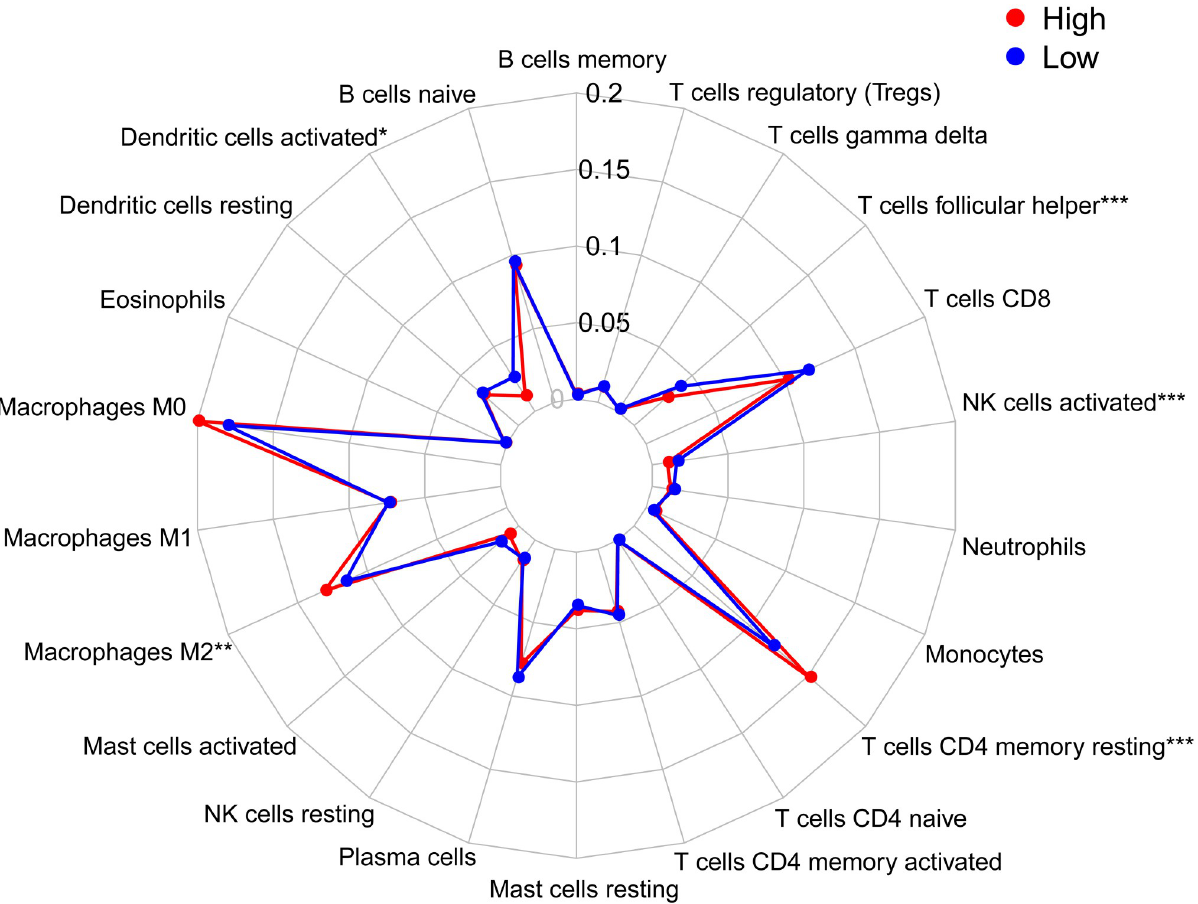
Fig 11. The radar charts depict a comparative summary of various immune cells in these two risk groups ( � P < 0.05, �� P < 0.01, ��� P < 0.001).